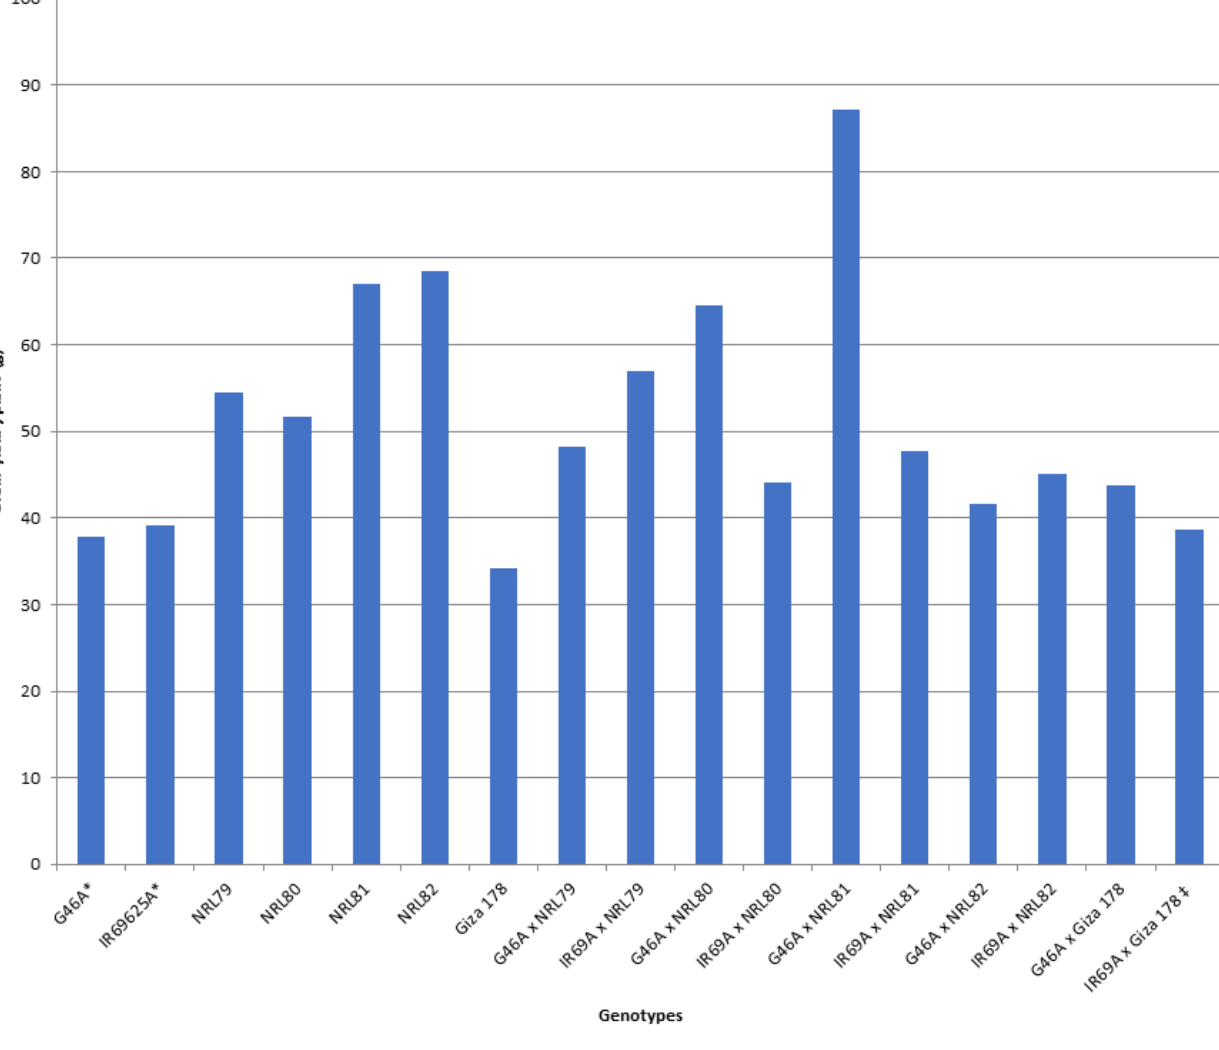
Figure 6. The mean performance for the grain yield/plant of the studied genotypes. *: The traits were recorded on maintainer lines that were related to CMS lines, ‡: Hybrid check.